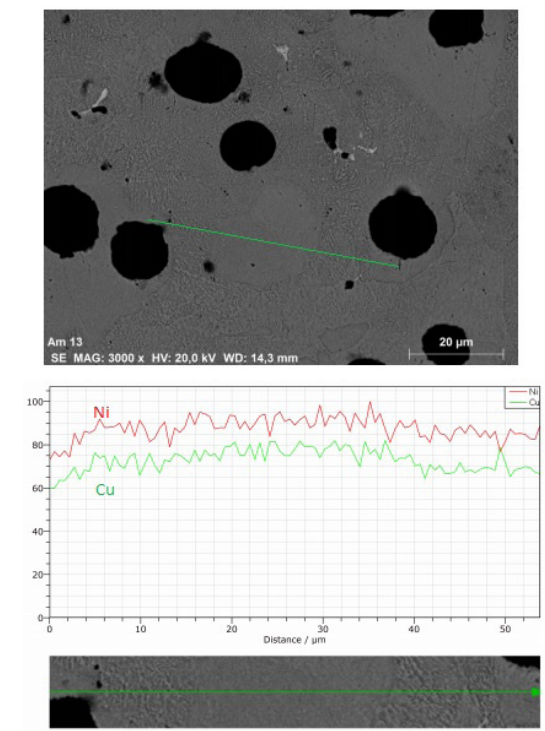
Figure 21. Ni/Cu EDS profile.